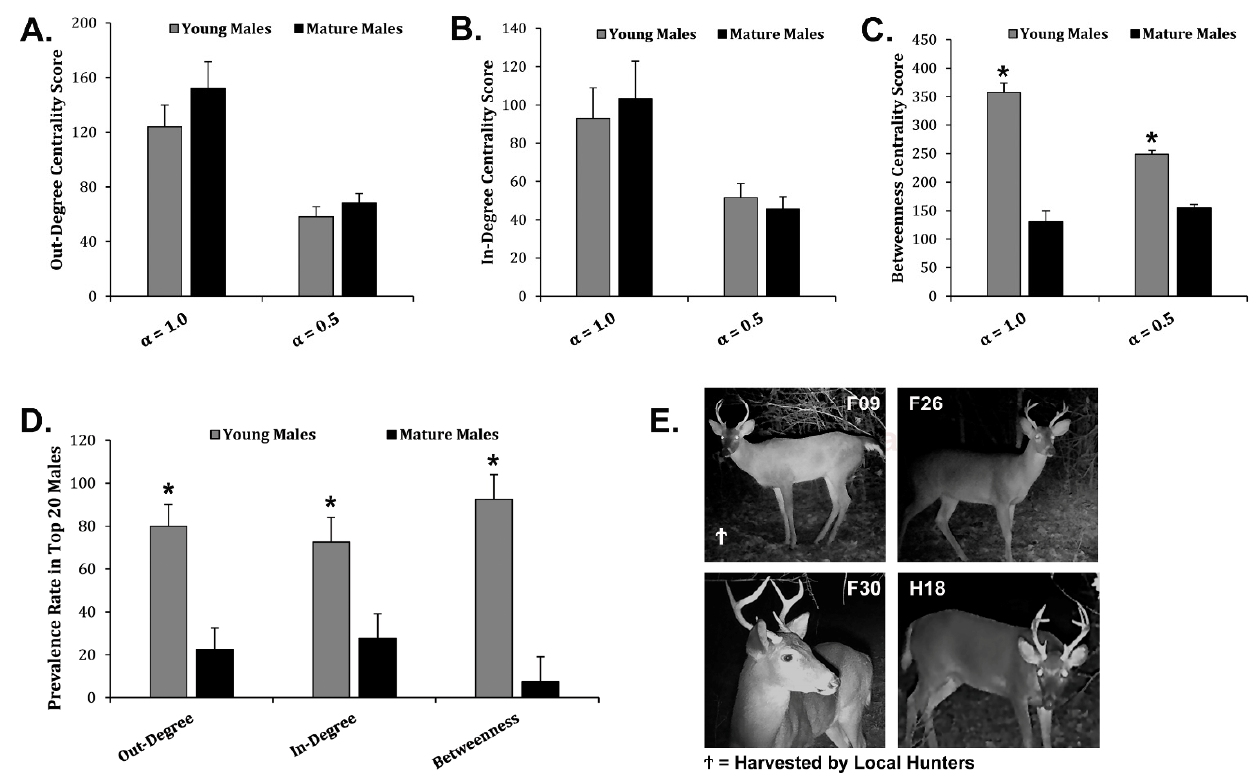
Figure 5. Age Structure of Potential Super-Spreaders. ( A ) The graph displays the Avg ± Stdev of out-degree centrality scores comparing young males and mature males using α = 1.0 or α = 0.5. ( B ) The graph shows the Avg ± Stdev of in-degree centrality scores comparing young males and mature males using α = 1.0 or α = 0.5. ( C ) The graph displays the Avg ± Stdev of betweenness centrality scores comparing young males and mature males using α = 1.0 or α = 0.5. ( D ) The graph shows the Avg ± Stdev of the prevalence in the top 20 males that were either young males or mature males among the top 20 out-degree, in-degree, and betweenness highest-ranking males. Statistical analysis was performed using a one-way ANOVA test, where * p < 0.05 was considered significant. ( E ) Shown are digital images of the highest ranking betweenness potential super-spreaders.